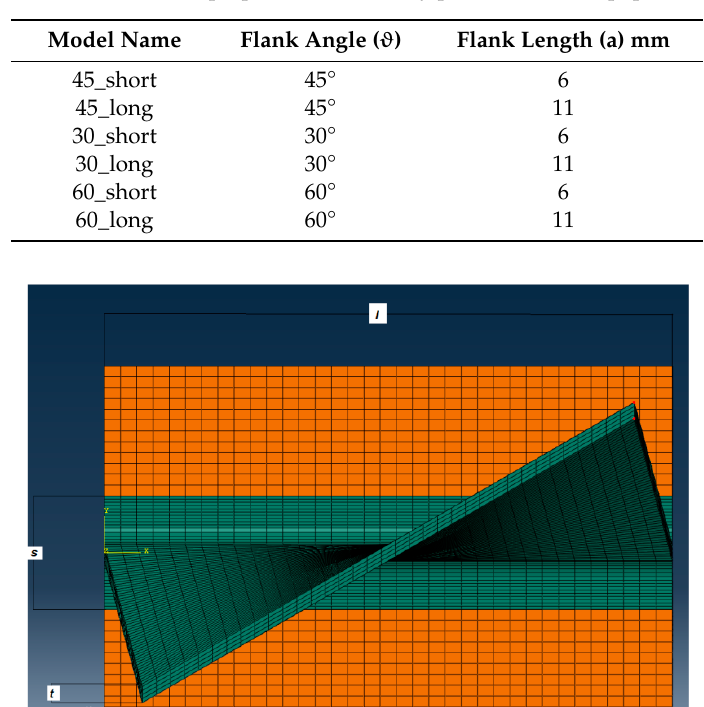
Table 1. Models prepared for the study presented in this paper.